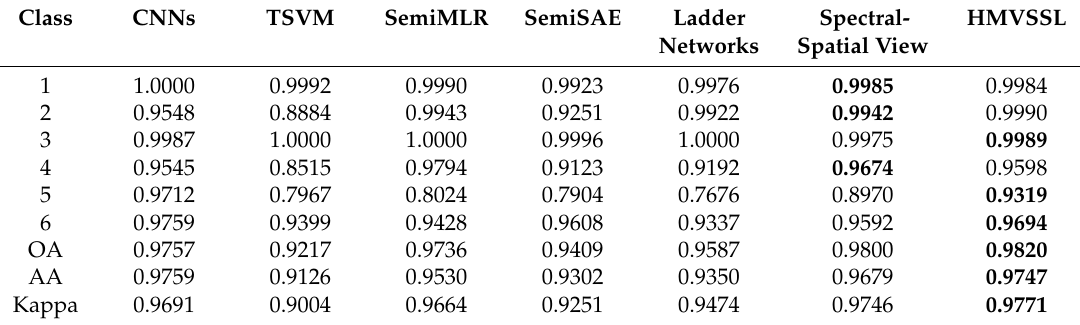
Table 3. Classification accuracies of the compared methods on JX_1